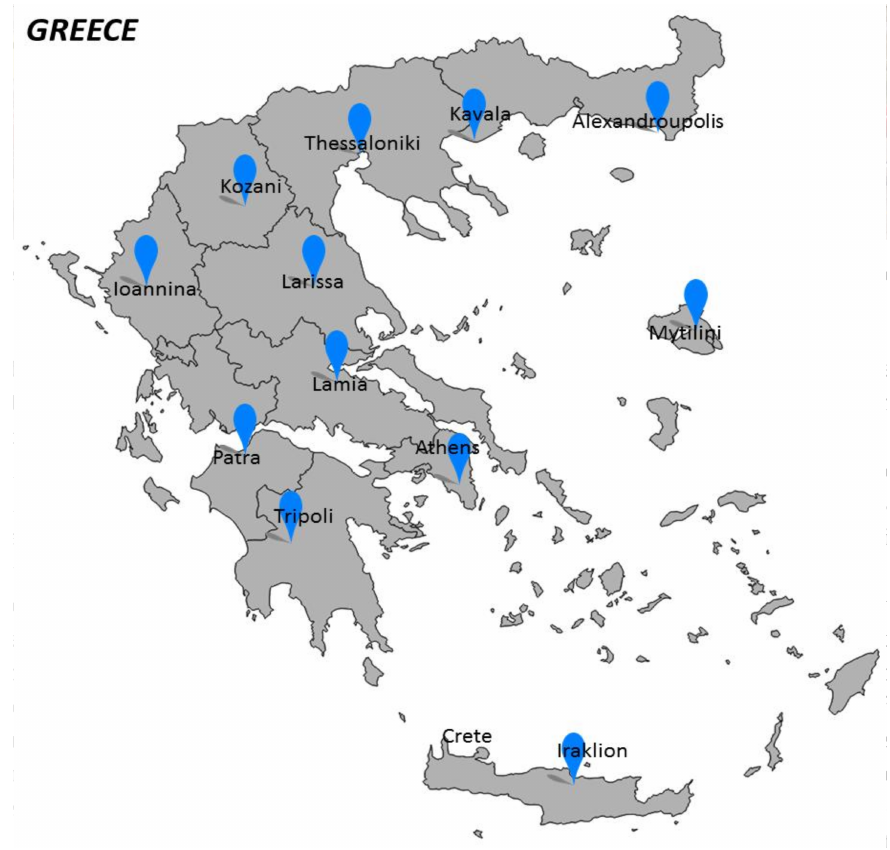
Figure 1. National Centres for Emergency Care (EKAB stations) in Greece. There are 12 EKAB stations in the major Greek cities: Athens, Thessaloniki, Patra, Iraklion (Crete), Larissa, Kavala, Ioannina, Alexandroupolis, Lamia, Mytilini, Tripoli, Kozani. Adapted from: https://www.ekab.gr/chorotaxiki- katanomi/